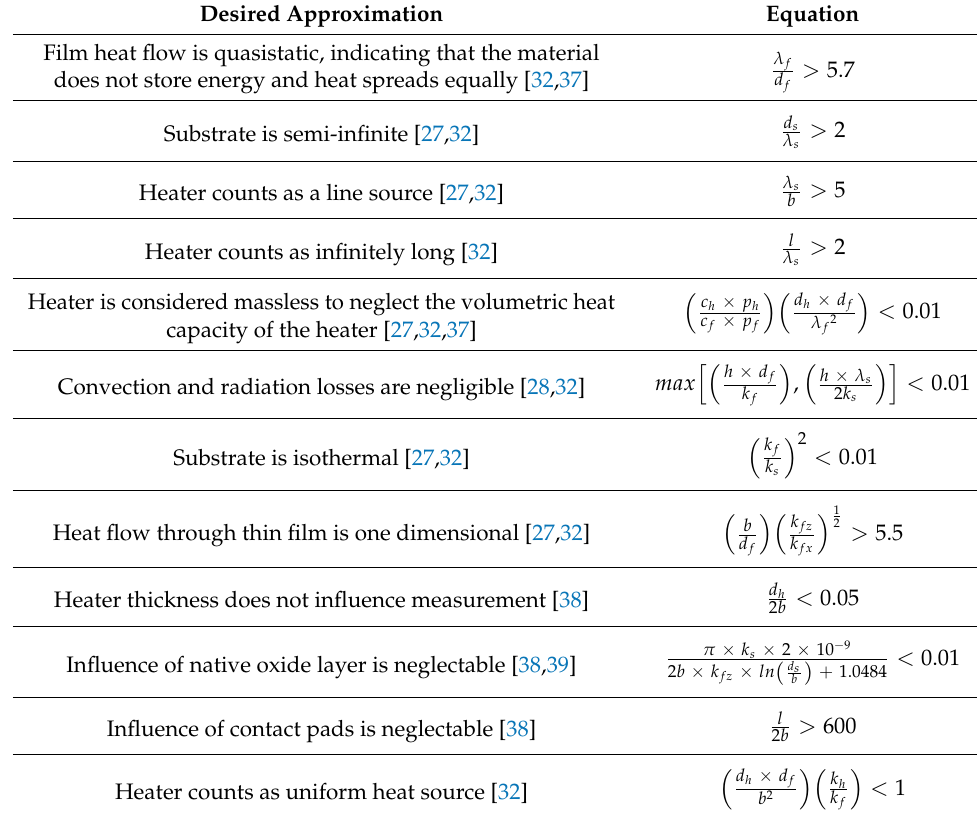
Table 1. Requirements for choosing valid heater geometries and measurement frequencies. Desired Approximation